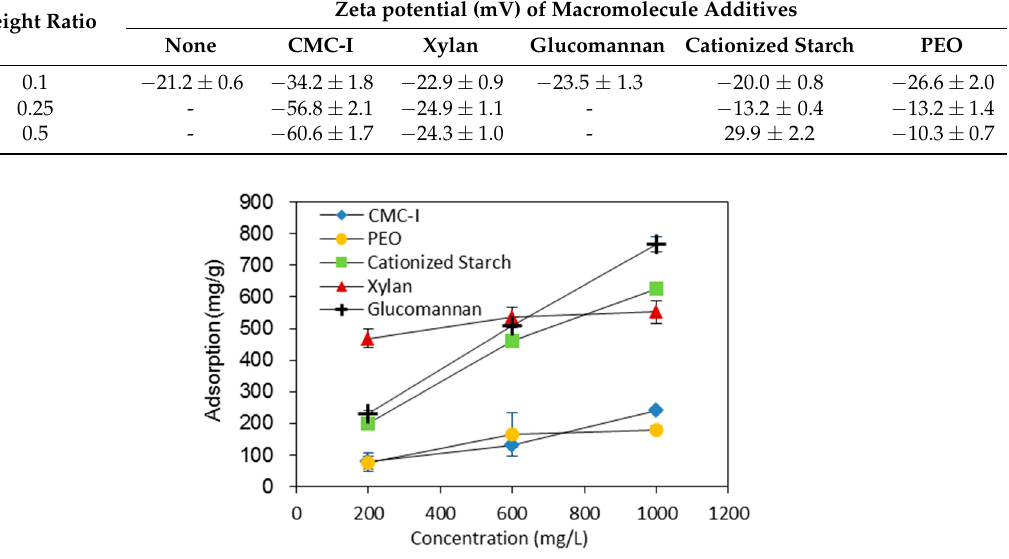
Figure 3. The adsorption of different macromolecules onto BC fibers at different concentrations.